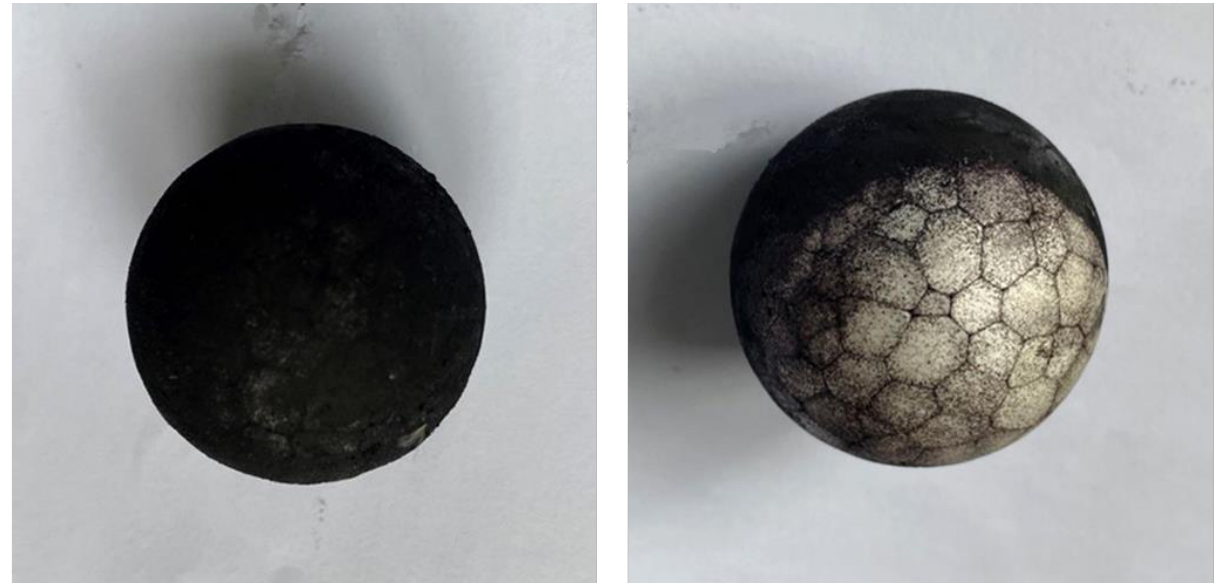
Figure 10. Sample of EPS floating ball after dyeing and